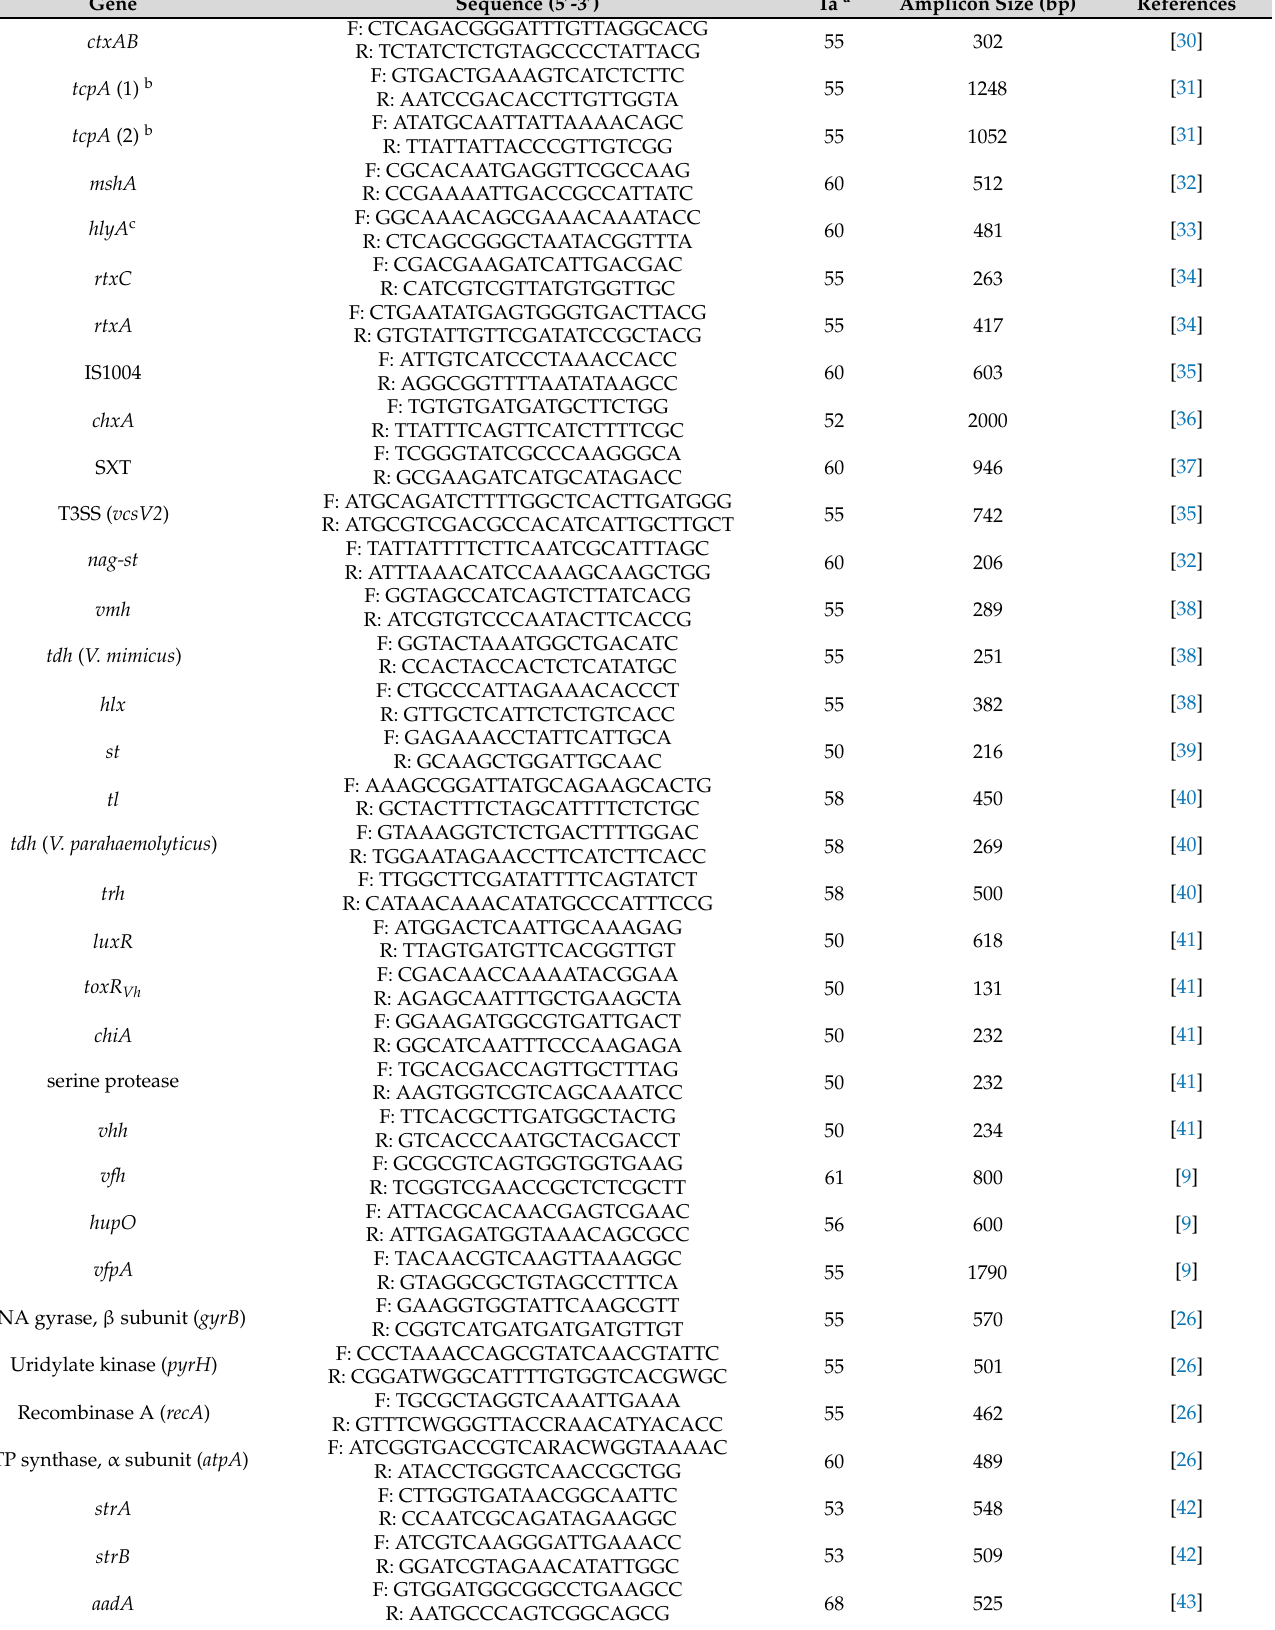
Table 1. Primers for virulence genes, MLST, and antibiotic-resistant